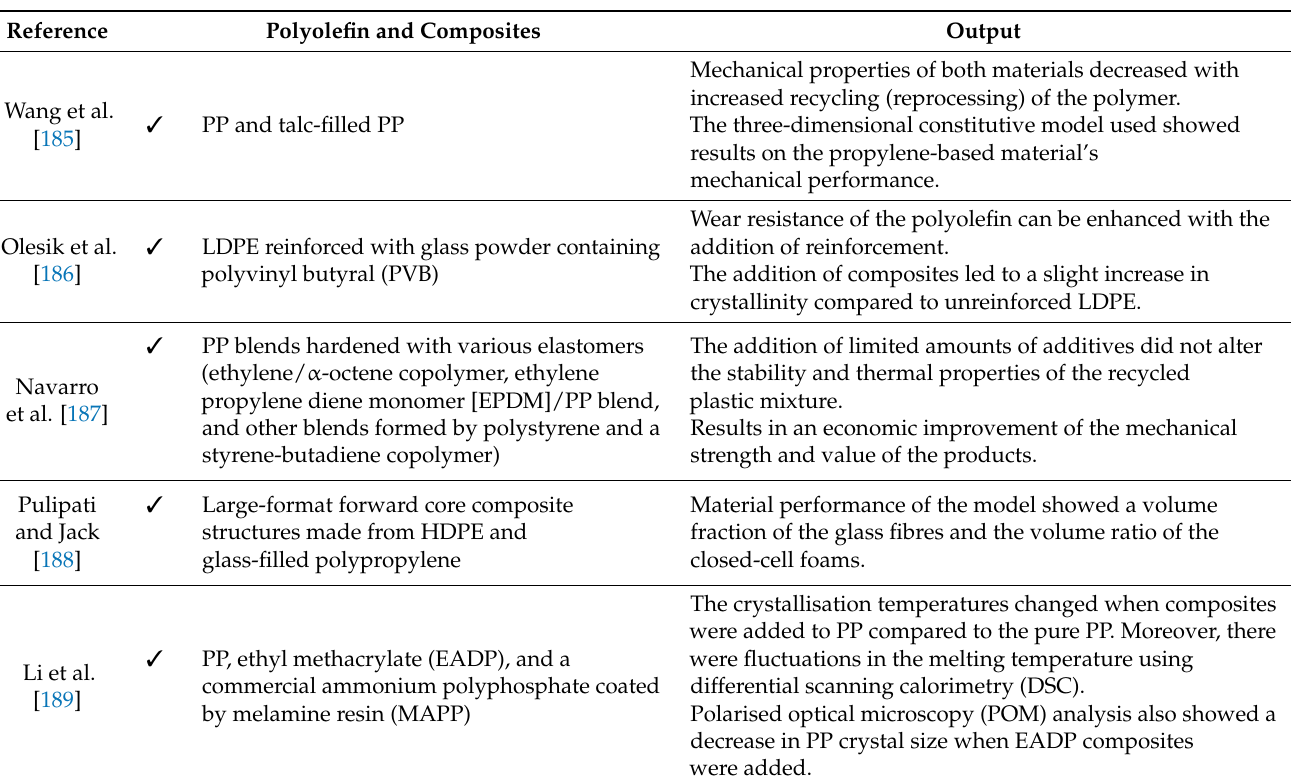
Table 5. Summary of effects of additives on the quality of polyolefins. LDPE—low-density polyethy- lene, HDPE—high-density polyethylene,